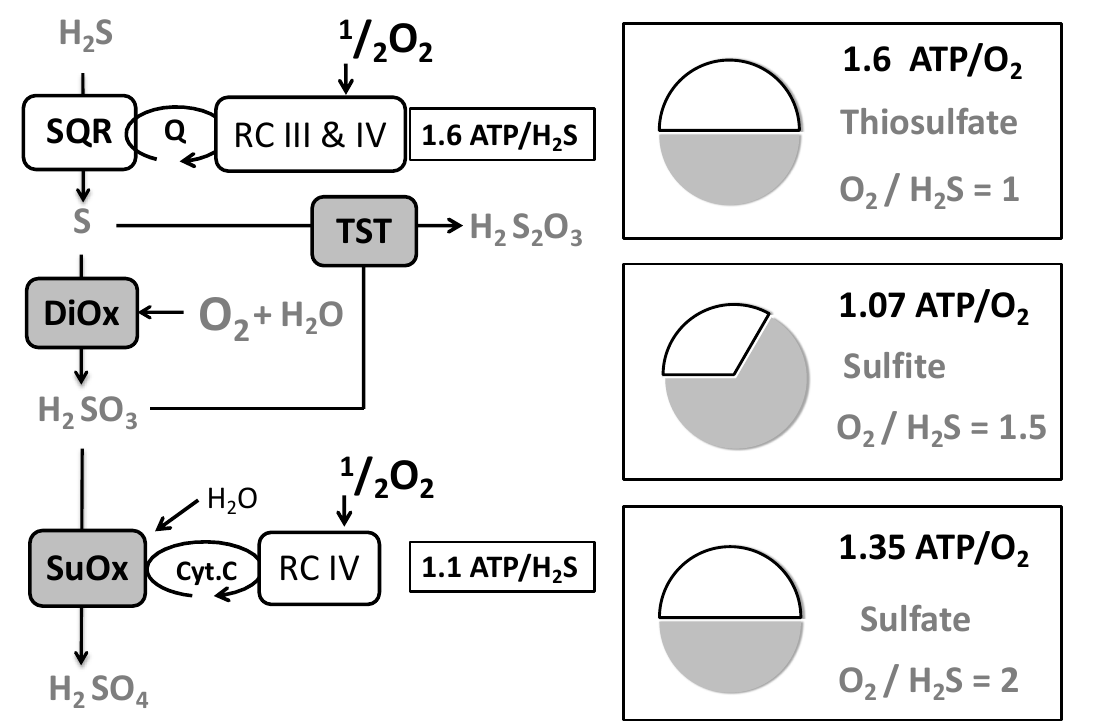
Figure 6. O 2 /sulfide ratio and ATP/O 2 ratio. ( Left ) sulfide oxidation pathway SQR releases S 0 that can be further oxidized by a dioxygenase (DiOx) presumably ETHE1, the resulting molecule H 2 SO 3 (sulfite) could be subject to the addition of another S 0 atom (from a second SQR reaction) by a sulfur transferase (TST), presumably rhodanese, to form thiosulfate (H 2 S 2 O 3 ) or to further oxidation into sulfate (H 2 SO 4 ) by sulfite oxidase (SuOx) that yields an electron to complex IV of the respiratory chain. When thiosulfate or sulfite are the final products, ATP production results from electron transfer from quinone to oxygen, hence 1.6 ATP per H 2 S engaged in the oxidation pathway. Thiosulfate formation consumes two sulfide and oxygen molecules, hence 3.2 ATP/2O 2 . If sulfite is the final product, one sulfide and 1.5 oxygen molecules are used, hence 1.6 ATP/1.5O 2 . When sulfate is the final product, sulfite oxidation with electron transfer from cytochrome-c to oxygen results in 1.1 ATP per sulfite, hence per H 2 S engaged in the oxidation pathway. The sum is therefore 2.7 ATP (1.6 + 1.1) and two oxygen molecules, hence 2.7 ATP/2 O 2 . ( Right ) resulting O 2 /H 2 S and ATP/O 2 ratios for the different sulfide oxidation products. The graphics show the relative contribution of respiratory chain (empty) and sulfur oxidation (gray) to oxygen consumption.